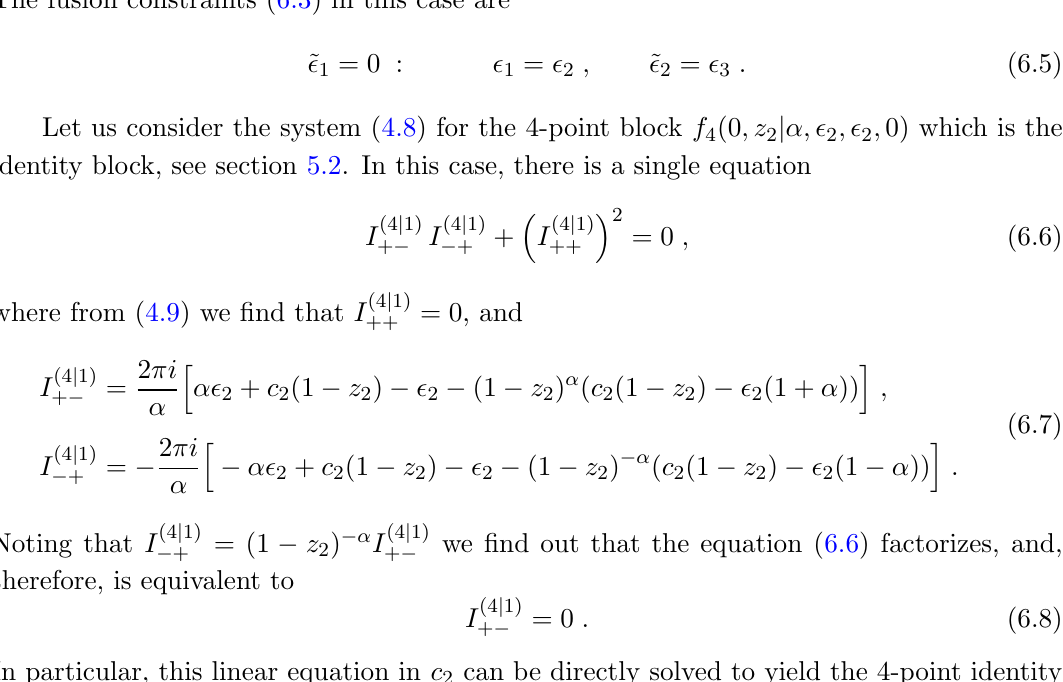
Figure 9 . Vacuum blocks with even n .